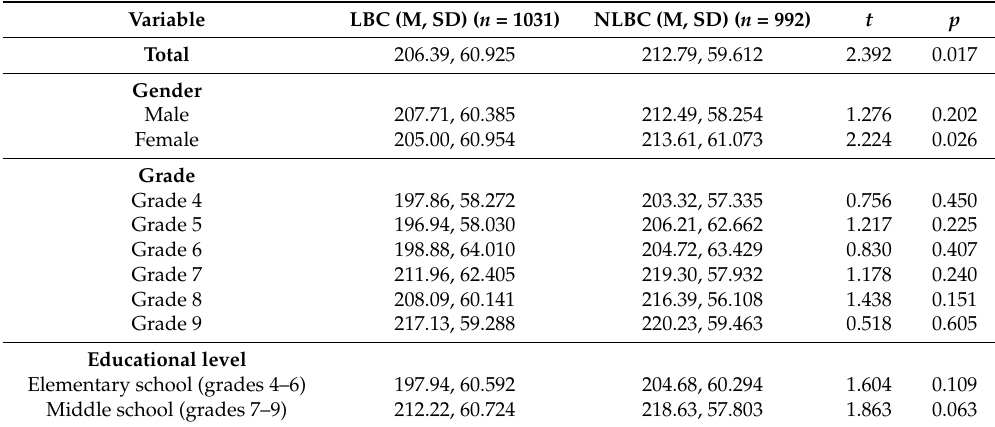
Table 3. Comparison of academic achievement of left-behind children (LBC) and non-left behind children (NLBC) in rural China.